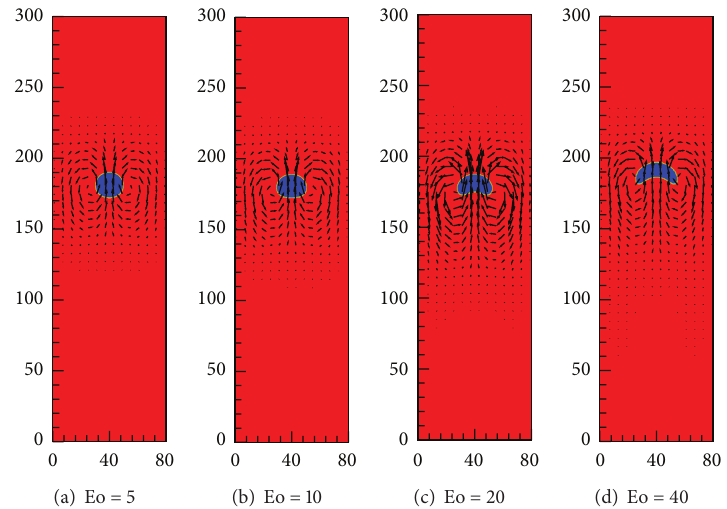
Figure 2: The contour of order parameter for different Eotvos numbers. The other parameters are 𝜌 𝐿 = 1.42 , 𝜌 𝐺 = 0.58 , and 𝜎 = 0.00521 .